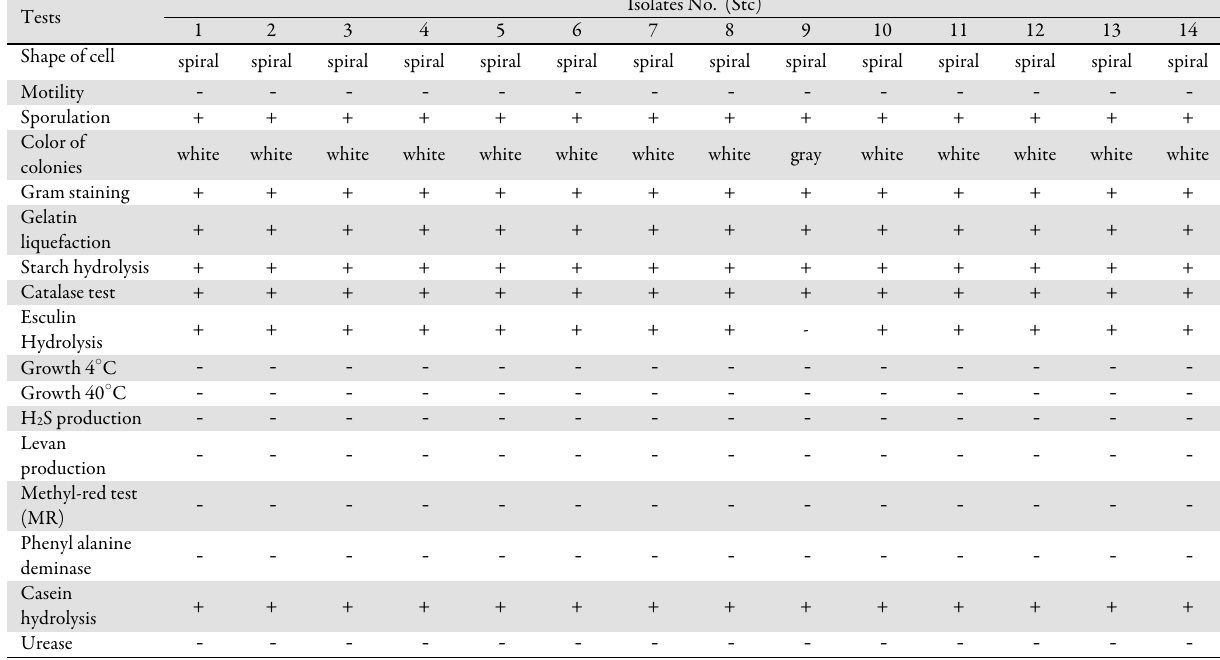
Isolates No. (Stc)